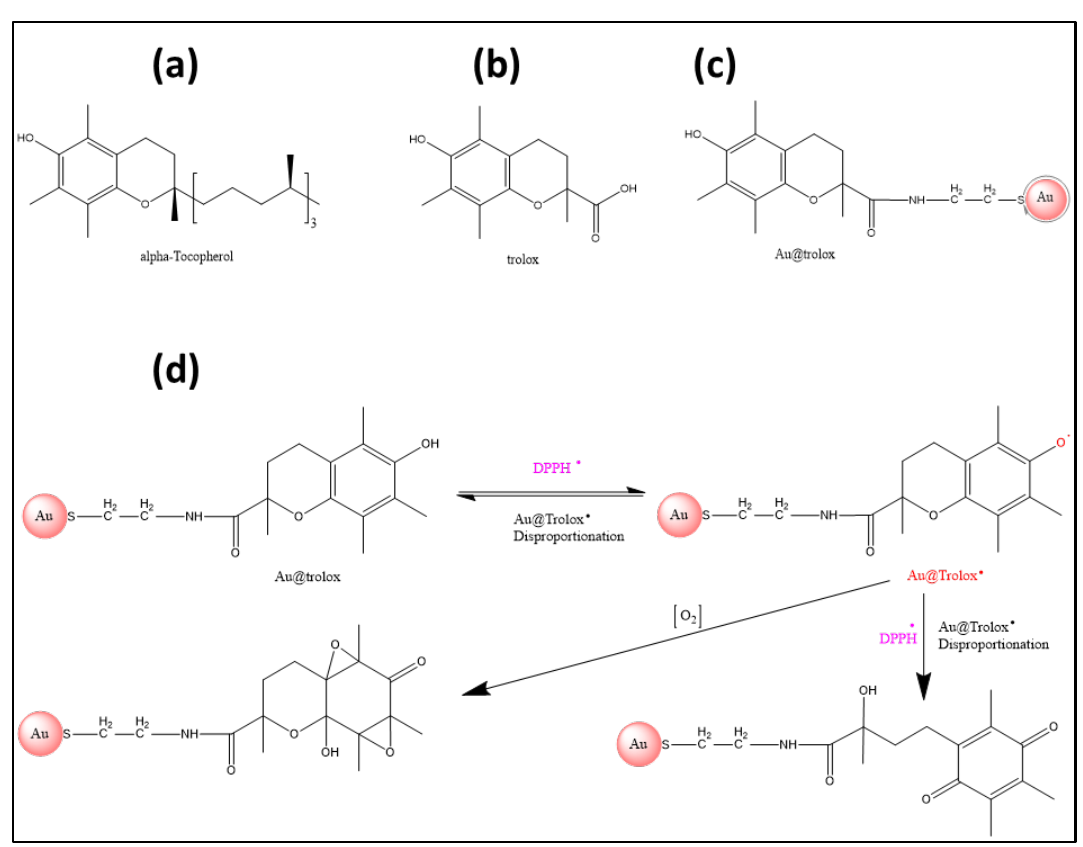
Figure 8. The molecular architecture of ( a ) alpha-tocopherol, ( b ) trolox, ( c ) trolox-functionalized AuNPs, and ( d ) reactions of Au@Trolox with DPPH• radicals.